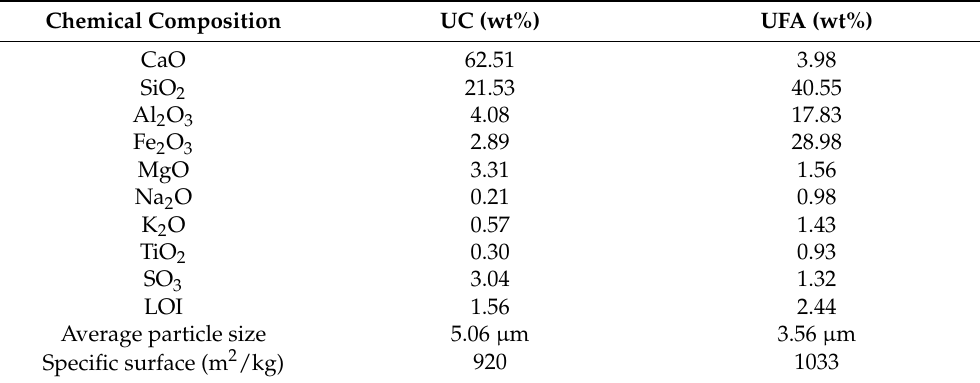
Table 1. Chemical composition and physical properties of the UC and UFA.